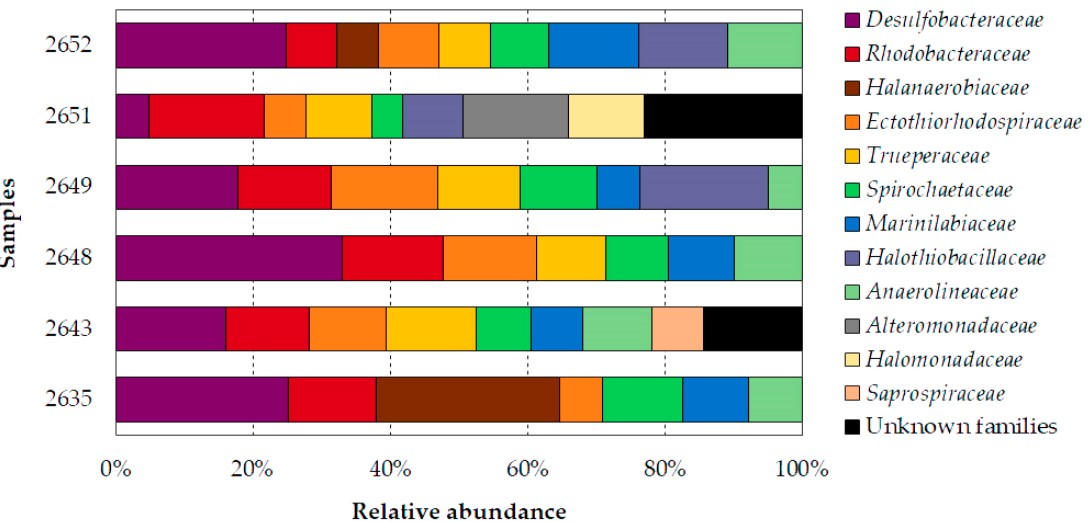
Figure 2. Relative abundance (%) of major families identified in sediment samples from Pétrola Lake. Only families with a relative abundance >2% of total bacteria population were included.